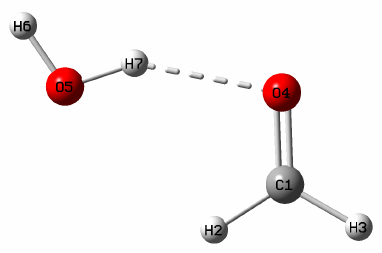
Figure 3. Formaldehyde molecule connected with one water molecule via a hydrogen